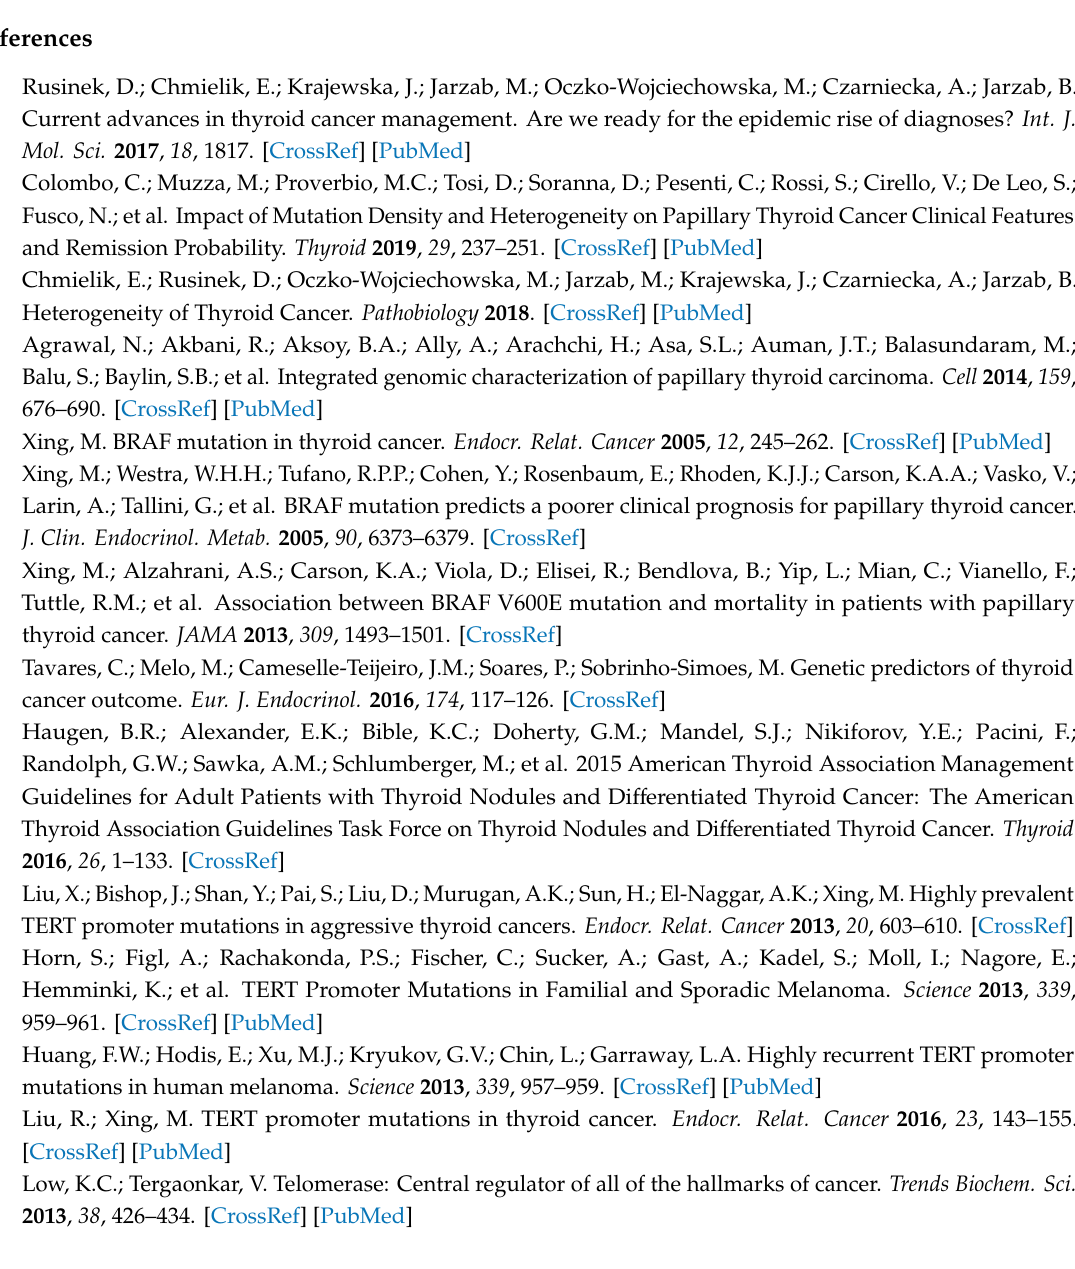
Table S1: The list of KRAS , NRAS , HRAS and BRAF mutations detectable by the Thyroid Cancer Mutation Analysis Kit (THDNA-RT64; EntroGen), Table S2: Lists of genes significantly deregulated depending on the molecular di ff erentiating factor; M- presence of BRAF or TERT p or RAS somatic mutation; NM- lack of somatic mutations within studied